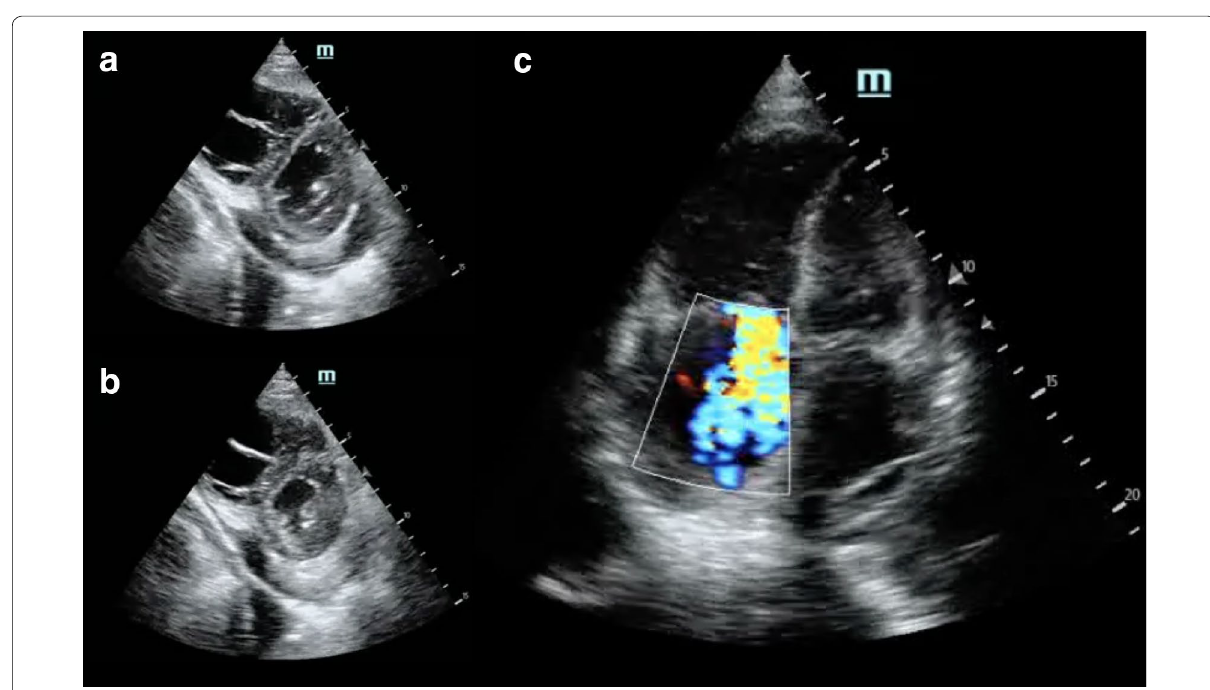
Fig. 2 Cardiac POCUS on Day 1, the parasternal short view demonstrated flattening of the interventricular septum only during diastole ( a ) and normalization during systole ( b ). The apical 4 view right ventricle was dilated with evidence of a tricuspid regurgitation jet ( c